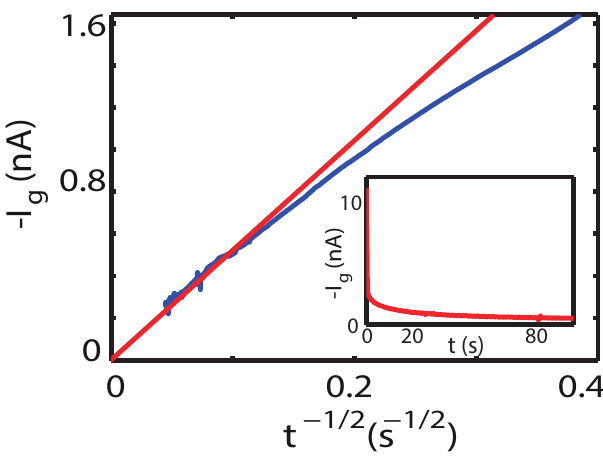
Figure 4. Plot of the gate current I g against against t − 1 2 . The behavior follows the Cottrell relationship for diffusion-limited electrochemistry. Inset: − I g vs. t. The polarization temperature is 210 K at V g = − 4 V.